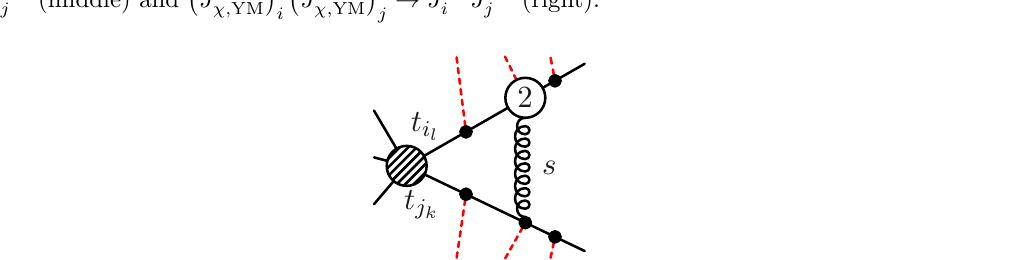
(cid:16) (cid:17) (cid:1) J T 1 (cid:31);(cid:24) i j !